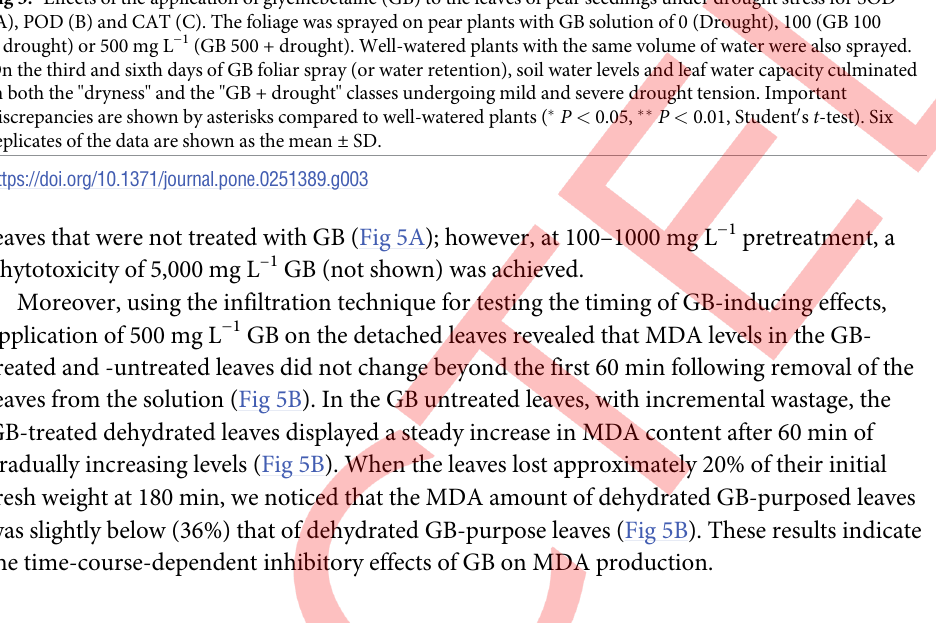
Fig 3. Effects of the application of glycinebetaine (GB) to the leaves of pear seedlings under drought stress for SOD (A), POD (B) and CAT (C). The foliage was sprayed on pear plants with GB solution of 0 (Drought), 100 (GB 100 + drought) or 500 mg L − 1 (GB 500 + drought). Well-watered plants with the same volume of water were also sprayed. On the third and sixth days of GB foliar spray (or water retention), soil water levels and leaf water capacity culminated in both the "dryness" and the "GB + drought" classes undergoing mild and severe drought tension. Important discrepancies are shown by asterisks compared to well-watered plants ( � P < 0.05, �� P < 0.01, Student 0 s t -test). Six replicates of the data are shown as the mean ± SD.